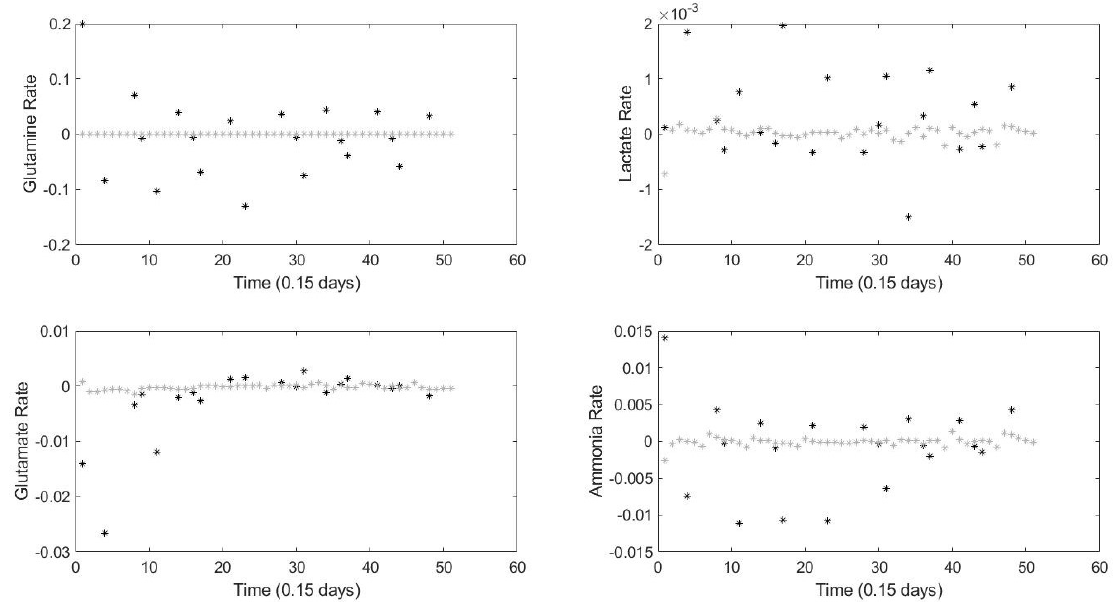
Figure 8. The process data (black) is compared with the model predictions batch (grey